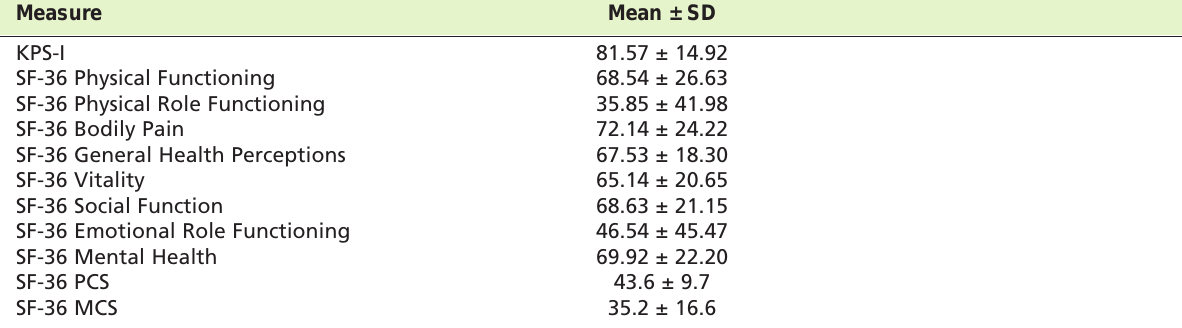
Descriptive Statistics for the PROMs Statistics Table III: